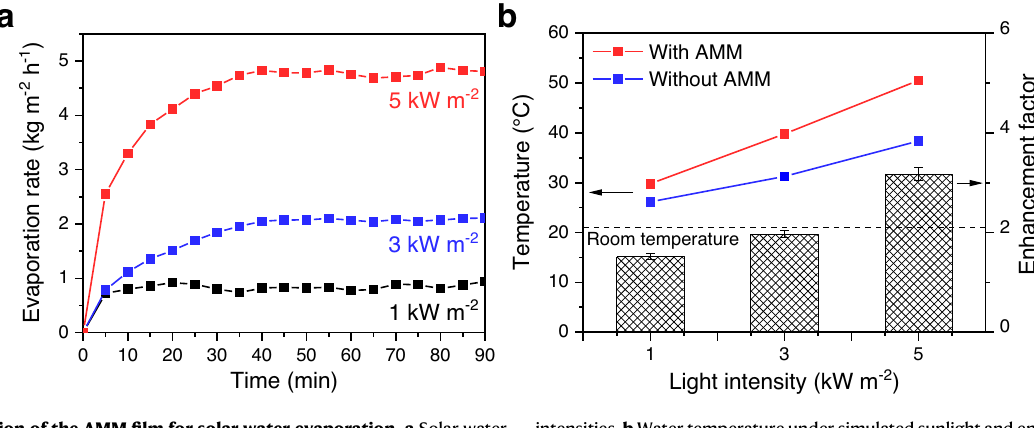
intensities. b Watertemperatureundersimulatedsunlightandenhancementfactor for the solar water evaporation rate with regards to pure